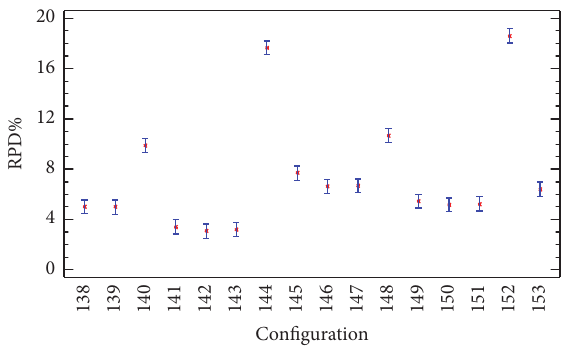
Figure 3: Means plot and Tukey’s HSD intervals at the 95% confidence level for 16 configurations of ILS DP.